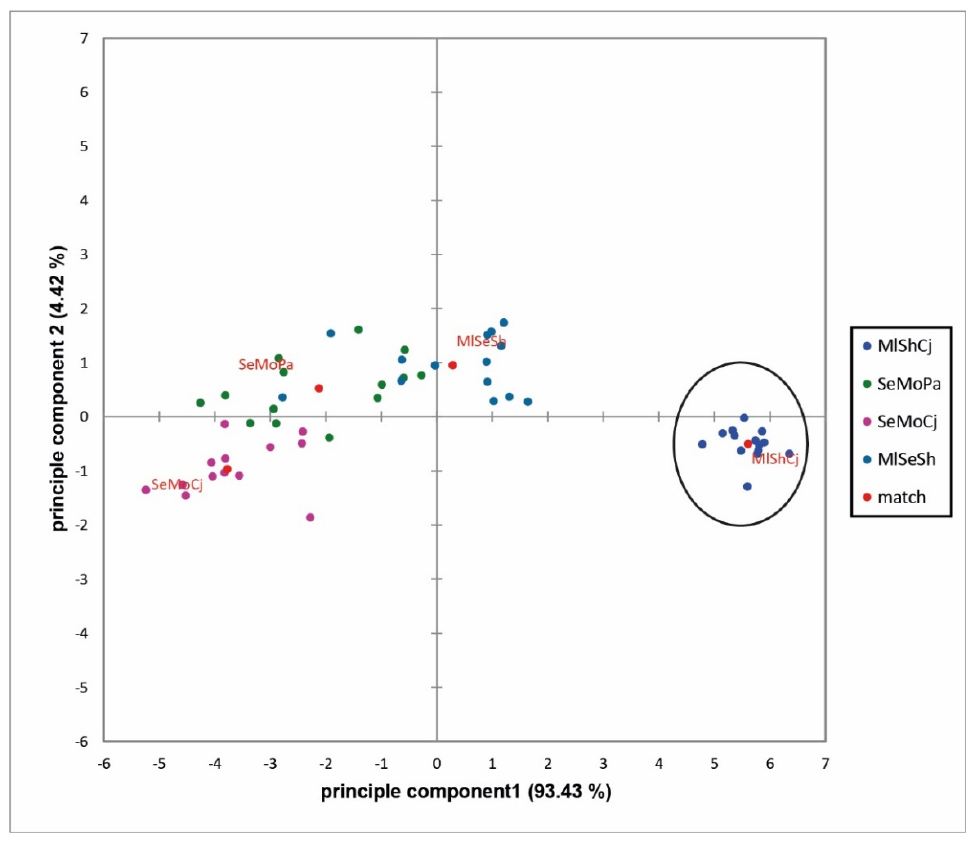
Figure 4. Object map of the samples (MlShCj = M. luteus + S. hominis + C. jeikeium ; SeMoPa = S. epidermidis + M. osloensis + P. aeruginosa ; SeMoCj = S. epidermidis + M. osloensis + C. jeikeium ; MlSeSh = M. luteus + S. epidermidis + S. hominis ).